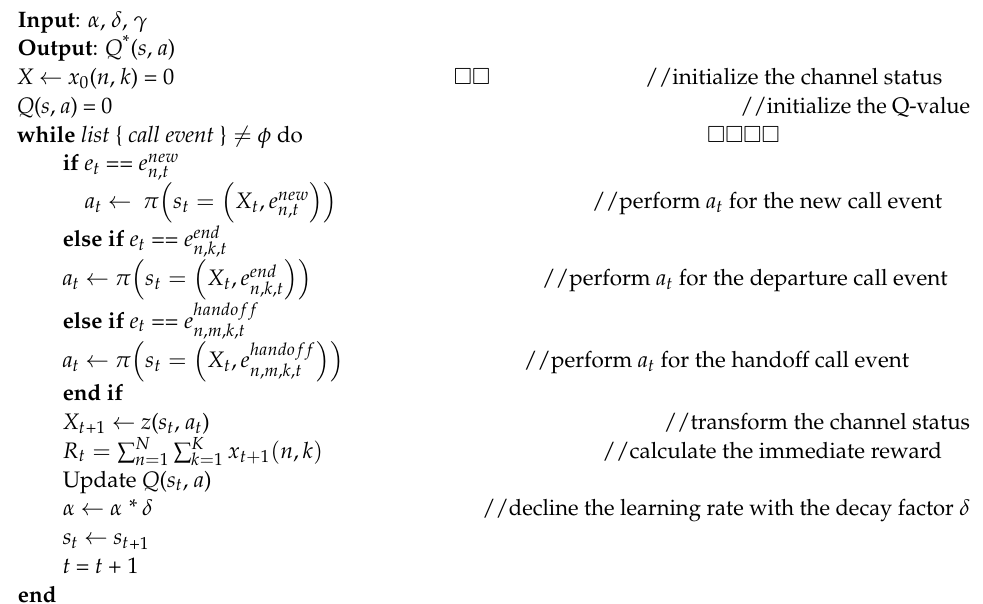
Algorithm 1: SARSA for solving the MDP